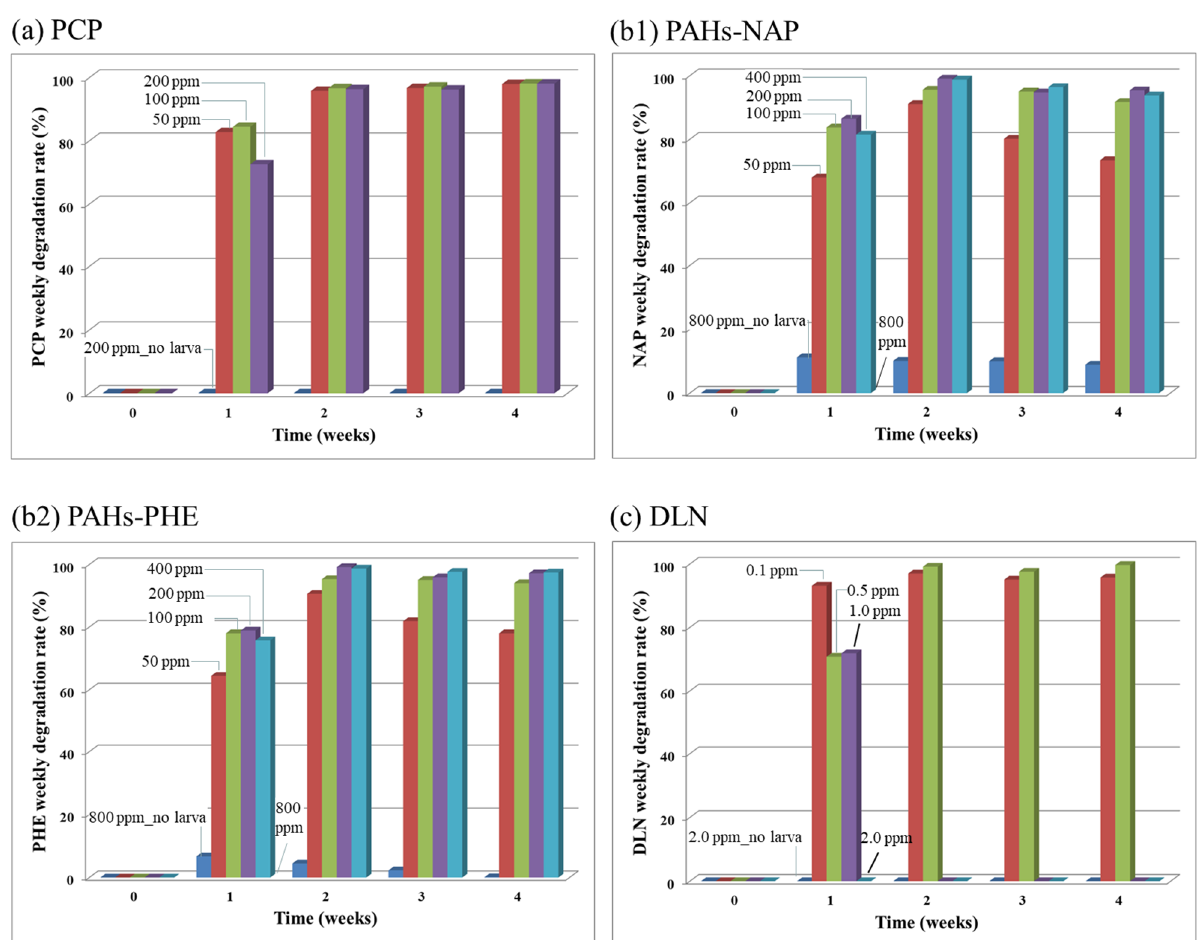
Figure 5. Weekly degradation rate of the tested PCP, PAHs-NAP and PHE and DLN, as labeled in ( a ), ( b1 ) and ( b2 ) and ( c ), respectively.